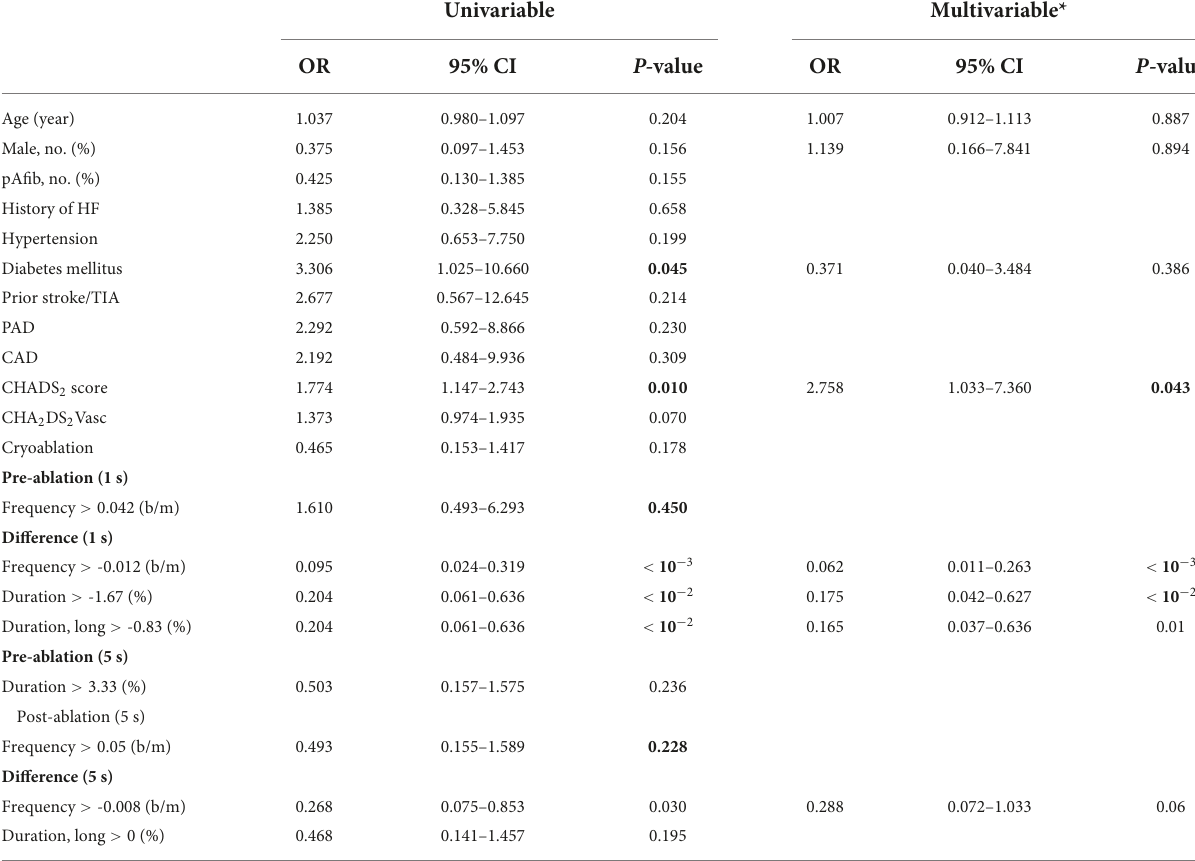
TABLE 5 Predictors of recurrent atrial fibrillation in the univariable and multivariable logistic regression model (1 and 5 s). Univariable